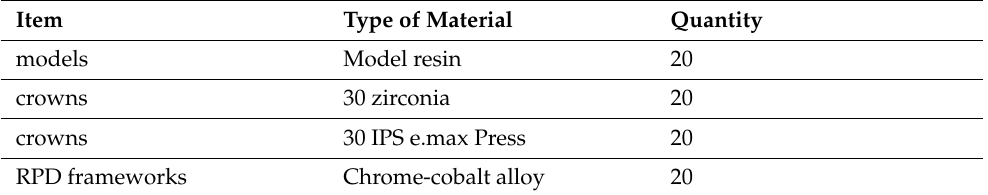
Figure 4. The final design of the sample. Table 1. The samples quantity, materials and types.